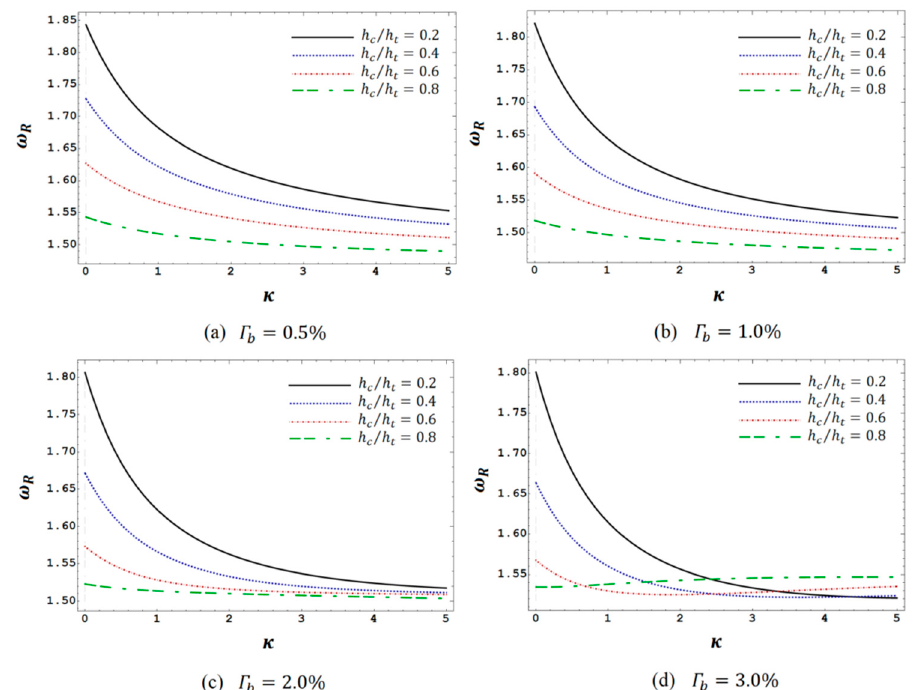
Figure 8. Variation of the first-order nonlinear-to-linear frequency ratio of a GPL-reinforced sandwich beam due to an increasing power-law parameter for different core-to-beam thickness ratios and total amounts of GPLs reinforcements in the beam ( N = 10, a / h t = 1, L / h t = 10 ).